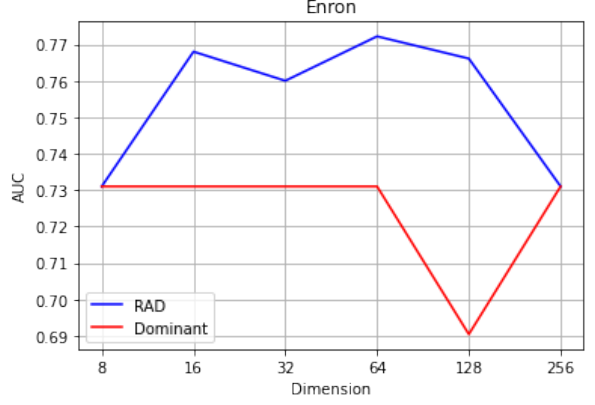
Figure 3. NodeAnomEn vs.